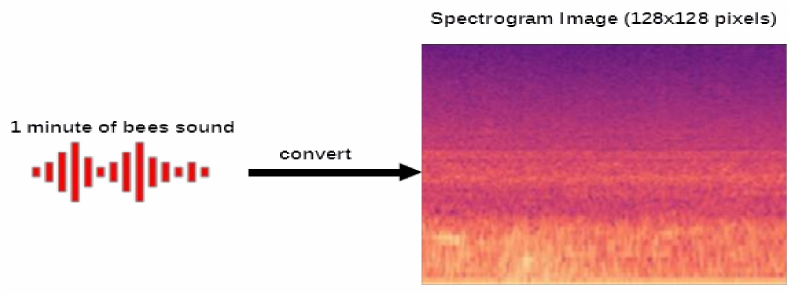
Figure 1. Conversion of bee raw sound data to 128-bin Mel spectrogram